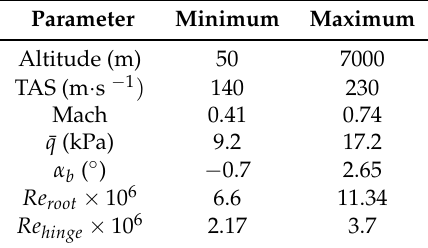
Figure 8. Selected flight conditions. Table 1. Range of simulation